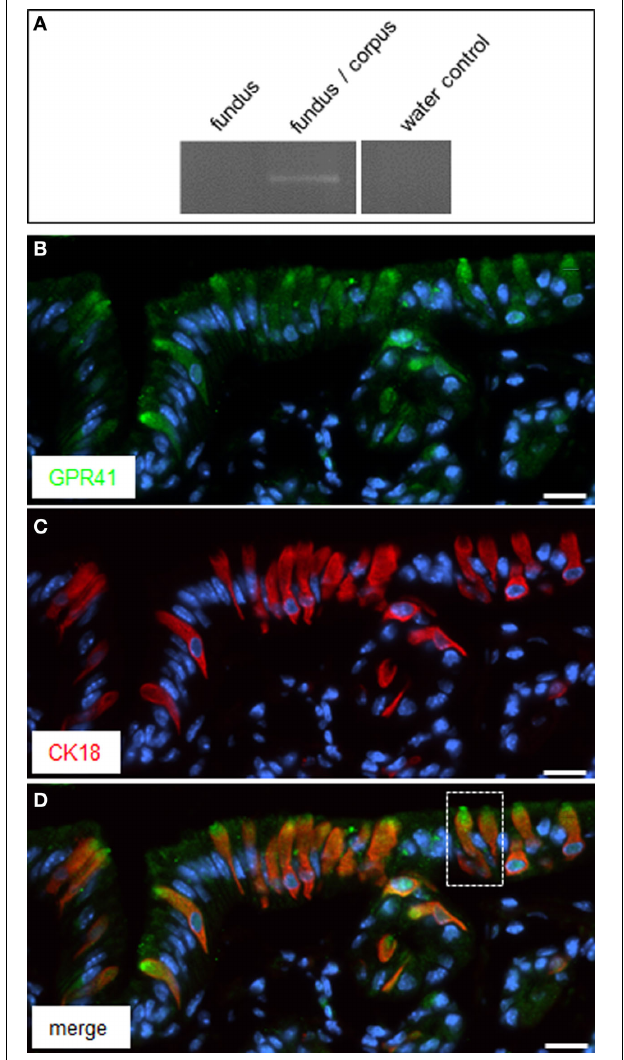
FIGURE 1 | Expression of GPR41 in CK18 positive brush cells at the “gastric groove.” (A) Reverse transcription polymerase chain reaction (RT-PCR) experiments were performed with primer pairs specific for GPR41 (455bp). Normalized cDNA from the fundus and fundus/corpus transition zone, respectively, was analyzed; for the fundus/corpus transition zone an amplicon of the expected size was obtained. Water control without template showed no amplicon. (B) Immunostaining of tissue sections of the corporal mucosa region underneath the “limiting ridge” with an antibody against GPR41. Several cells exhibited immunoreactivity (green ) most prominent at their apical pole. (C) The CK18-antibody revealed a staining pattern (red ) reminiscent of that in (B ) except staining of the most apical cell pole. (D) Overlay of (B) and (C) clearly demonstrated co-expression of GPR41 and CK18 in the same population of cells but different subcellular staining patterns for both antibodies. Magnification of the boxed area is shown in Figures 2A–C . Sections were counterstained with DAPI ( blue ). Scale bars : (B–D) = 20 μ